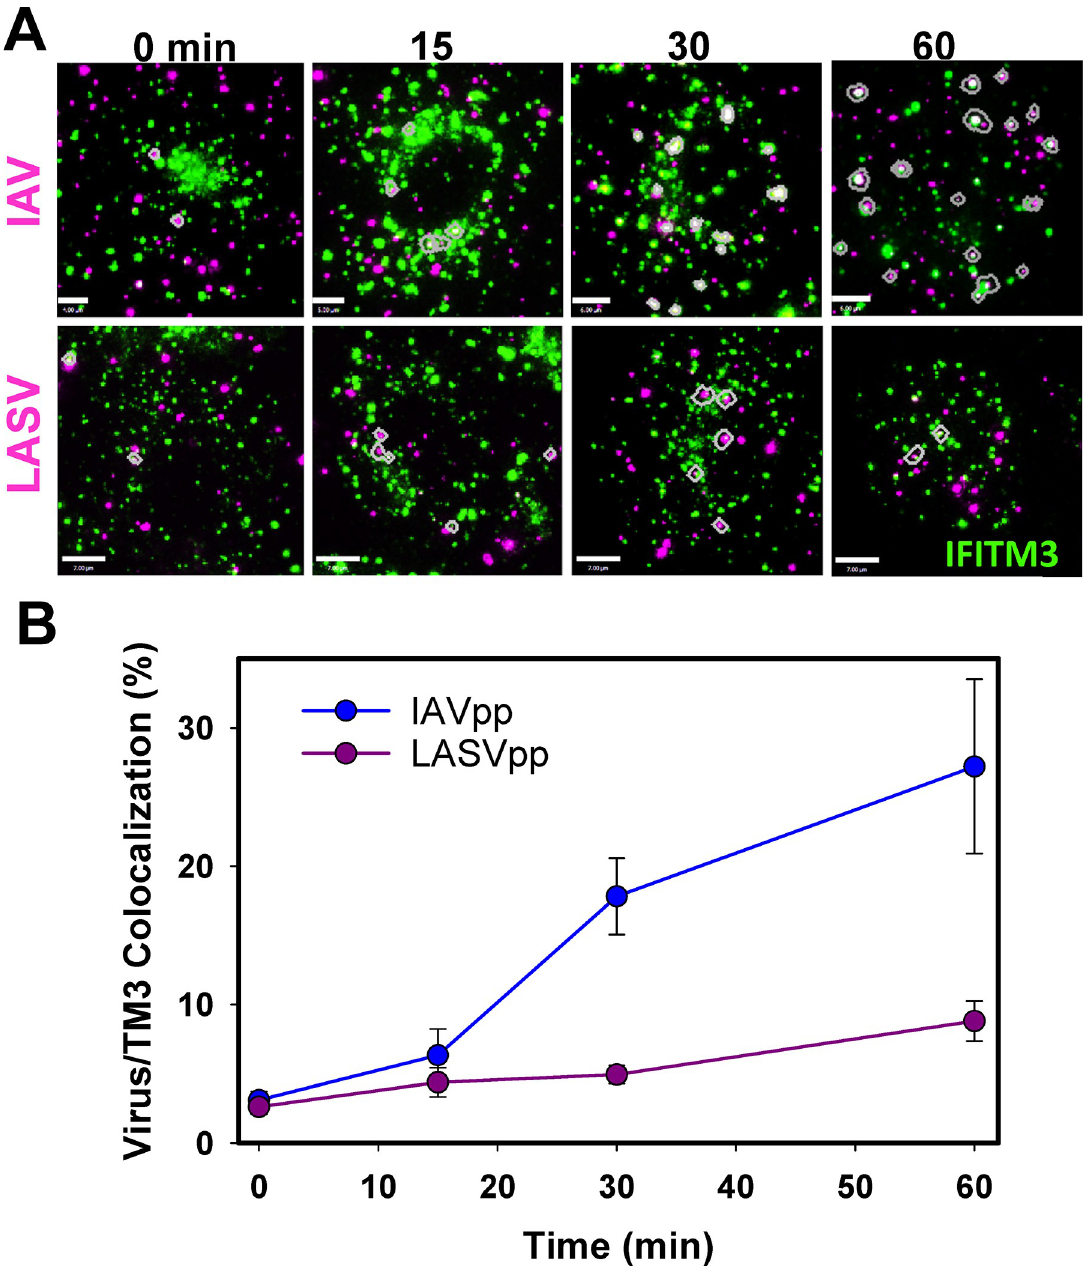
Fig 7. IAV but not LASV particles colocalize with IFITTM3-containing vesicles. A549 cells expressing IFITM3-imNG were incubated in the cold for 1.5 hr with particles pseudotyped with IAV HA/NA or LASV GPc and labeled with HIV-1 Gag-mCherry (red). Cells were washed to remove unbound viruses, incubated at 37˚C for varied times, fixed in 4% paraformaldehyde and imaged. (A) Representative images at different time points show IAVpp (top) and LASVpp (bottom) co-localization with IFITM3-imNG (green) containing vesicles in A549 cells. The colocalized particles are circled in magenta. Scale bar 3 μ m (top and bottom). (B) Quantification of IAVpp and LASVpp colocalization with IFITM3-imNG endosomes over time. Data at each time point are mean ± SEM from at least 5 different fields of view containing multiple